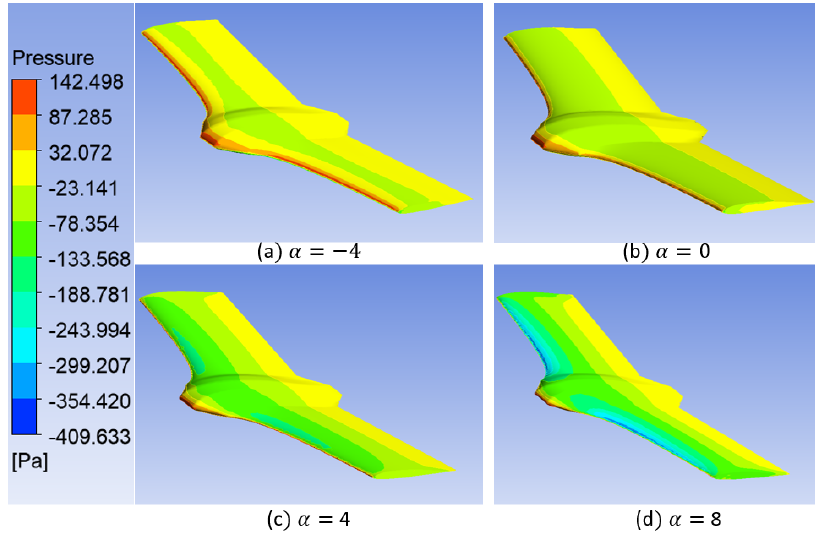
Figure 16. Pressure distribution on the tail-sitter surface at different angles of attack at upper surface.